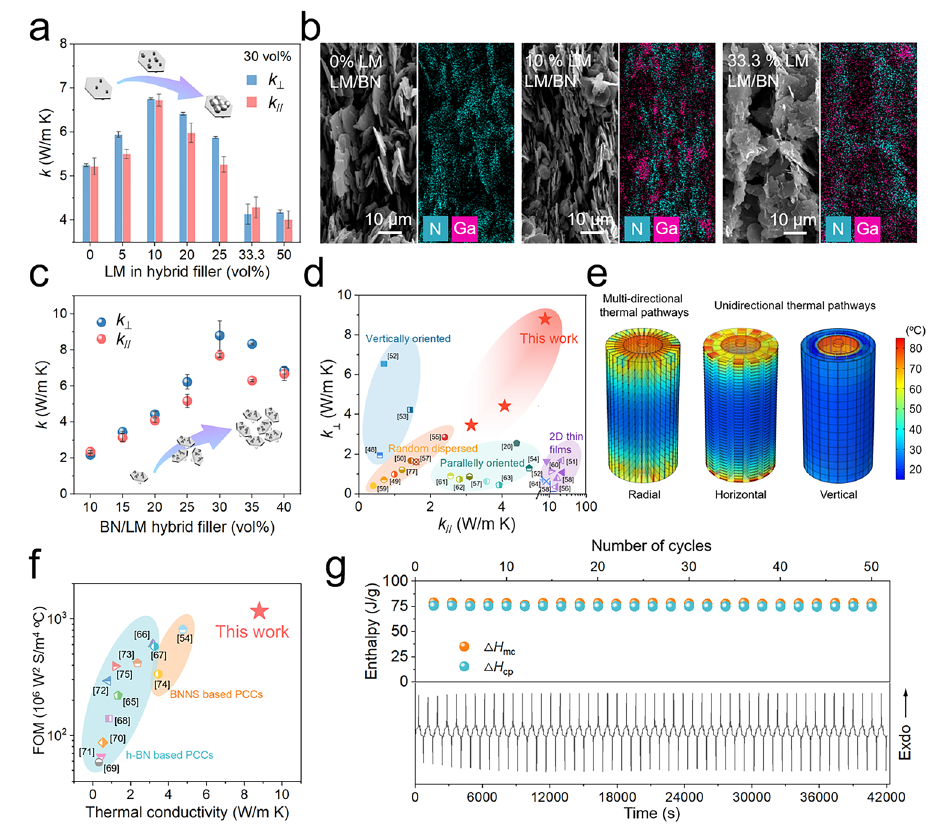
Fig. 3 a k ⊥ and k // of the PEG/LM/BN composites as a function of the LM content in hybrid fillers (~ 10 μm). Note that the total volume frac- tion of LM/BN hybrid fillers in composites is a constant value of 30%. b SEM images taken from the longitudinal section and the correspond- ing nitrogen and gallium element mapping of the PEG/LM/BN composites incorporating 30 vol% LM/BN hybrid fillers (~ 10 μm) with LM content of 0, 10 and 33.3 vol%, respectively. c k ⊥ and k // of the PEG/LM/BN composites as a function of the volume fraction of the binary LM/ BN hybrid fillers (~ 18 μm). d Comparison of k ⊥ and k // of our PEG/LM/BN composites with previously reported BN-based polymer composites [48–64]. e Direct temperature distribution of simulated model of PEG/LM/BN composites with radial, horizontal and vertical orientations which are used to carry out battery thermal management, calculated by finite element simulation (FES). f Comparison of the figure of merits and k of BN-based phase change composites from the latest studies [54, 65–75]. g Calculated enthalpy of melting and crystallization (top) and the differ- ential scanning calorimetry profiles (bottom) of the PEG/LM/BN composite with the highest k for 50